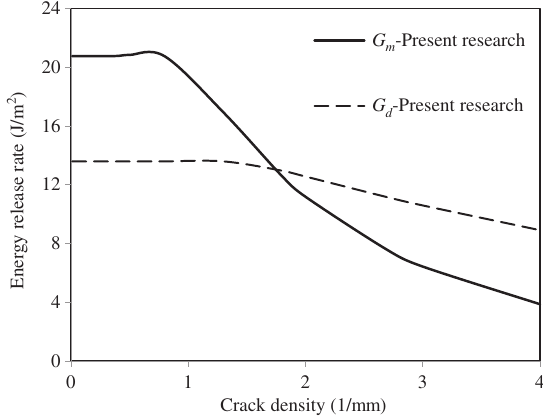
Figure 15: Crack density vs. energy release rate for [40/−40] s carbon/ epoxy laminate under σ